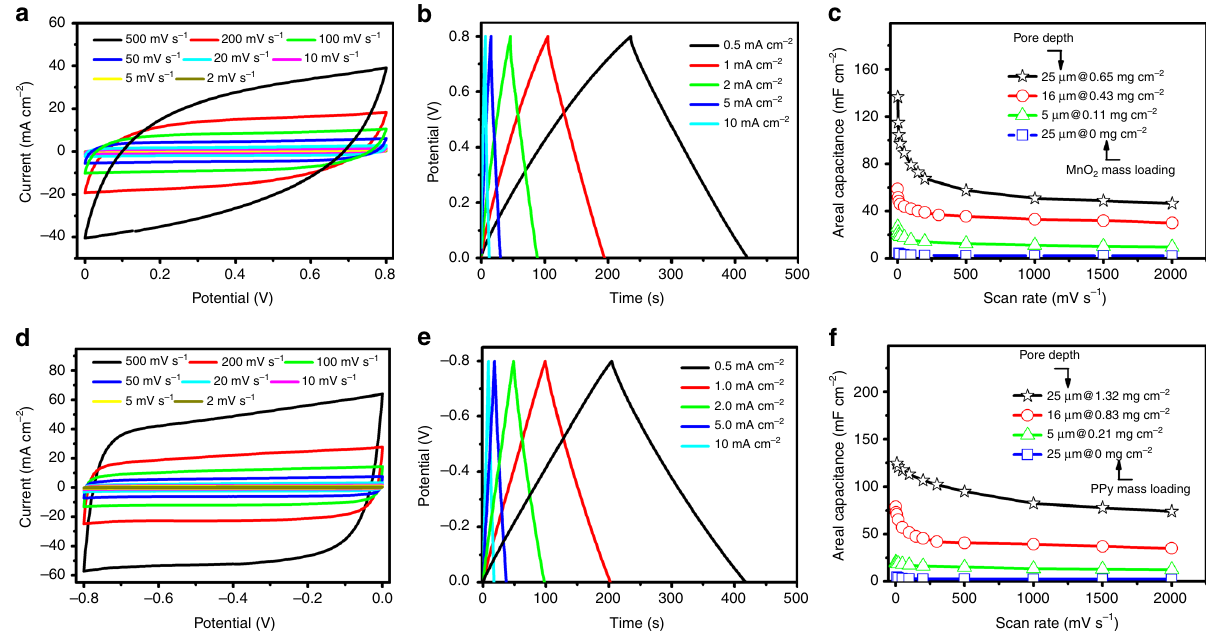
Fig. 3 Electrochemical performance of symmetric MSCs based on HAN-based nanoelectrodes. a CV curves at different scan rates, b GCD pro fi les at different current densities, and c device areal capacitance as a function of scan rates of HAN@SnO 2 @MnO 2 //HAN@SnO 2 @MnO 2 MSCs, respectively. d CV curves at different scan rates, e GCD pro fi les at different current densities, and f device areal capacitance as a function of scan rates of HAN@SnO 2 @PPy//HAN@SnO 2 @PPy MSCs,